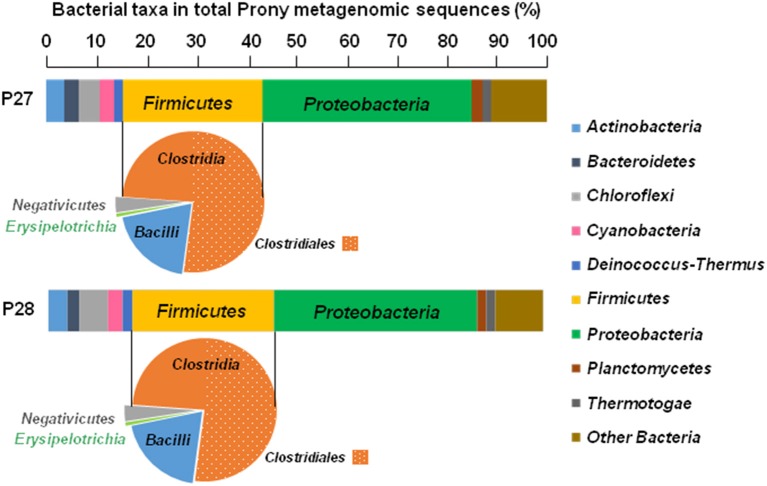
Distribution and taxonomic assignments of total bacterial sequences in Prony Hydrothermal Field metagenomes P27 and P28 obtained from ST09 site. The histogram shows the relative abundance of major bacterial phyla in the total bacterial metagenomic sequences and pie charts show distributions of major Firmicutes classes.